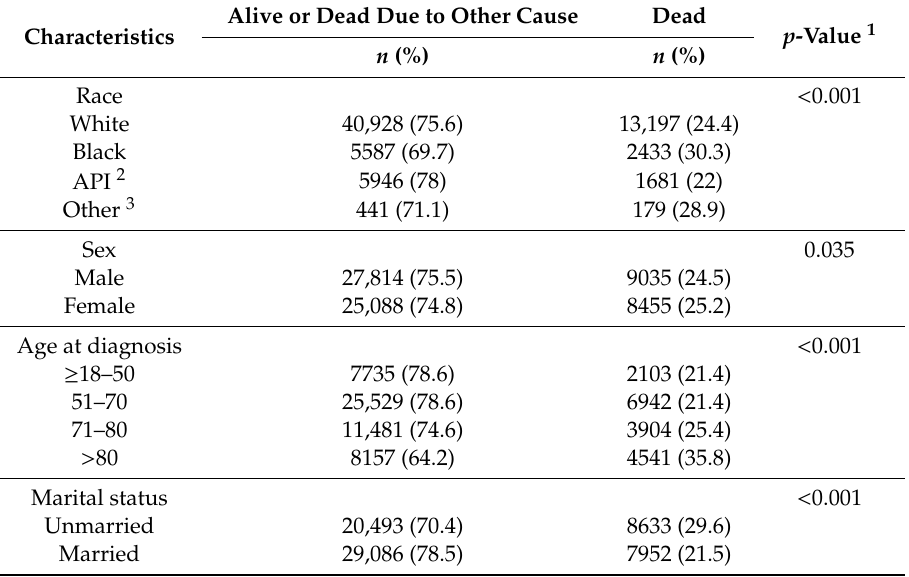
Table 2. Characteristics of colorectal cancer patients according to colorectal cancer specific mortality in the US during 2007 and